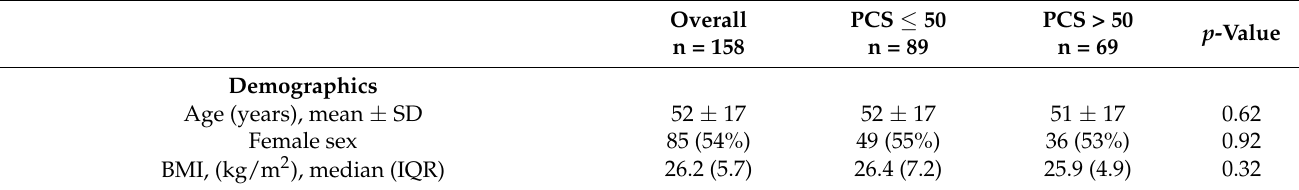
Table 2. Descriptive and clinical characteristics by physical component summary of